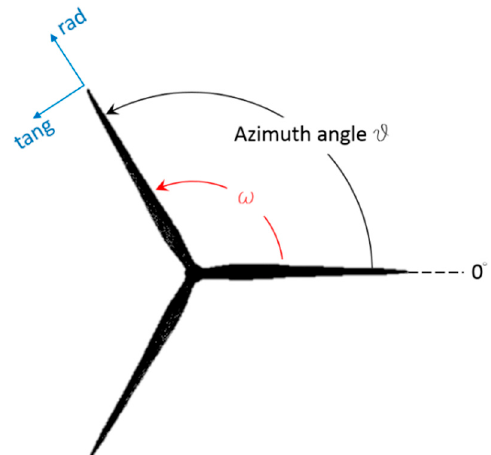
Figure 4. Notation adopted for the blade azimuth angle, ϑ , and the components of the forces and velocities.